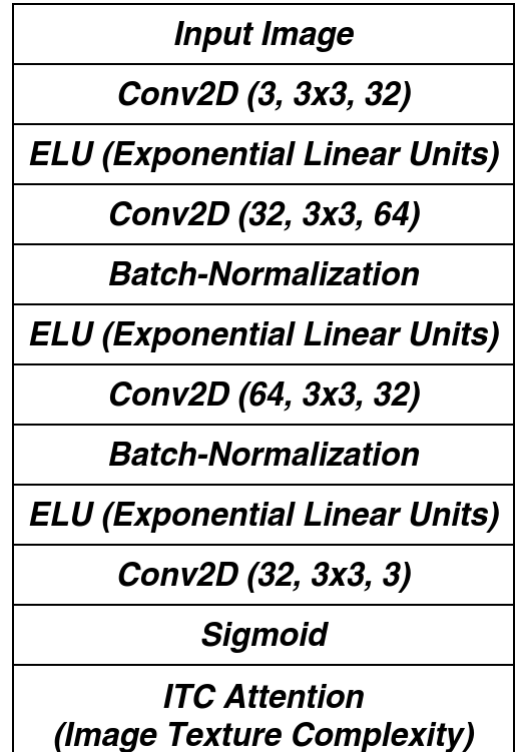
Figure 4. ITC attention model architecture.